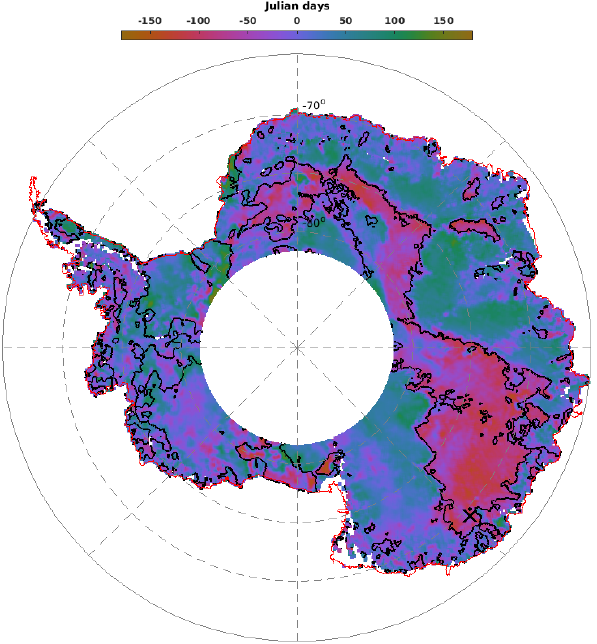
Figure 4. Difference of the seasonal date of maximum backscatter- ing coefficient between the Ku and Ka bands. Blue defines a max- imum in the Ka band before the Ku band while the magenta the inverse. Black contour lines delineate regions where the backscat- tering coefficient at the Ku band peaks before April. The cross mark represents the location of the time series shown in Fig. 1. White ar- eas indicate regions where no observations are available (latitudinal orbit limit of 81.5 ◦ S). The color bar is cyclic and defines the Julian